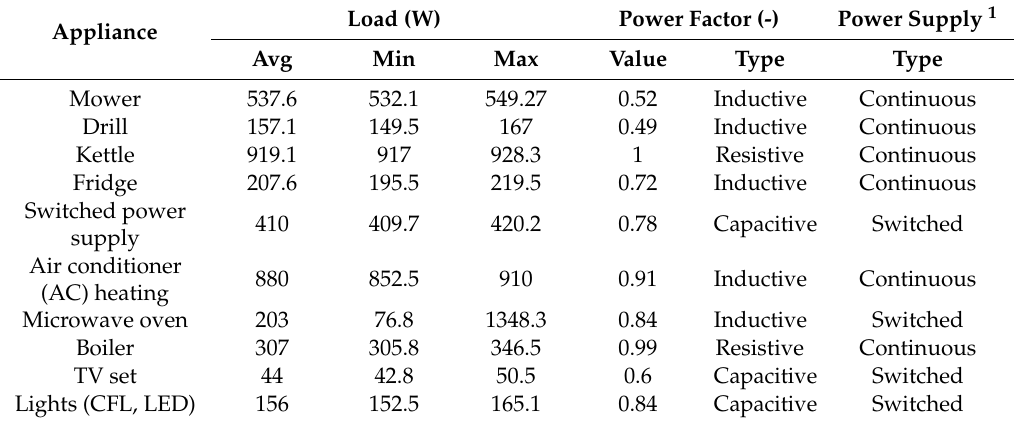
Table 3. The properties of the appliances for their relevancy